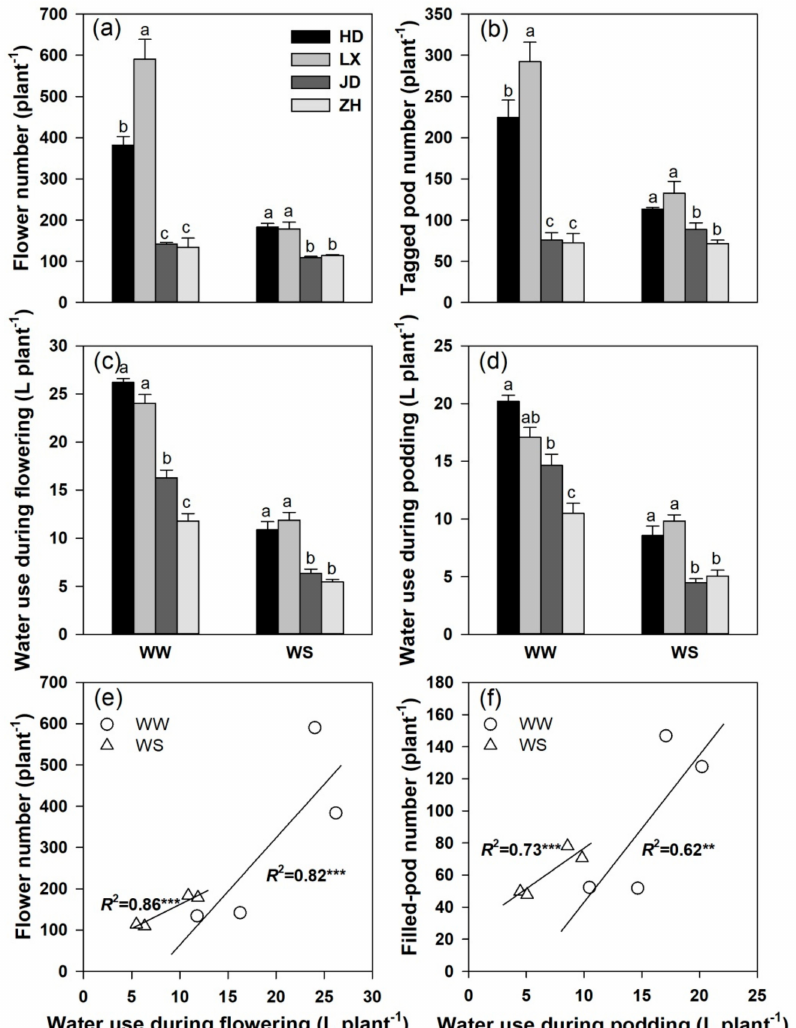
Figure 6. Flower number ( a ), tagged-pod number ( b ), water use during flowering ( c ), water use during podding ( d ), the relationship between water use during flowering and flower number ( e ), and the relationship between water use during podding and filled-pod number ( f ) for four soybean genotypes (two landraces: Huangsedadou (HD), Longxixiaohuangpi (LX), and two recent cultivars: Jindou 19 (JD) and Zhonghuang (ZH)) under well-watered (WW) and cyclical water stress (WS) imposed from 40 days after sowing in the pot experiment in 2014. Note changes in the y -axes in each part and the changes in the x -axes in ( e , f ). A number of tagged pods did not produce seeds so that filled-pod numbers were smaller than tagged-pod numbers. The bars indicate one standard error of the mean ( n = 4). Means ( a – d ) in the same panel with di ff erent letters di ff er significantly at p = 0.05. The regression coe ffi cients ( R 2 ) of the fitted linear regressions in ( e , f ) are shown: ** p < 0.01, *** p <